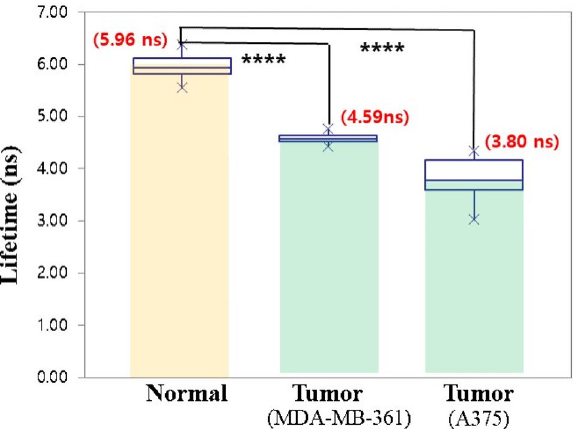
Figure 6. Difference in fluorescence lifetime between the normal tissues and two tumor tissues. (**** P < 0.0001) (Number of normal tissues = 20, Number of breast tumor tissues = 10, Number of skin tumor tissues =